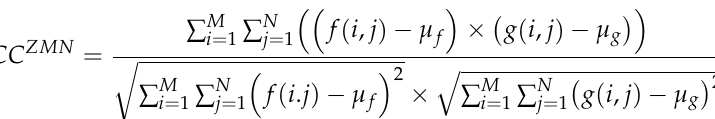
Figure 4. ( a ) Specimen prepared (painted) for optic measurement, ( b ) virtual measurement base used to calculate strain, and ( c ) base used to calculate displacement.